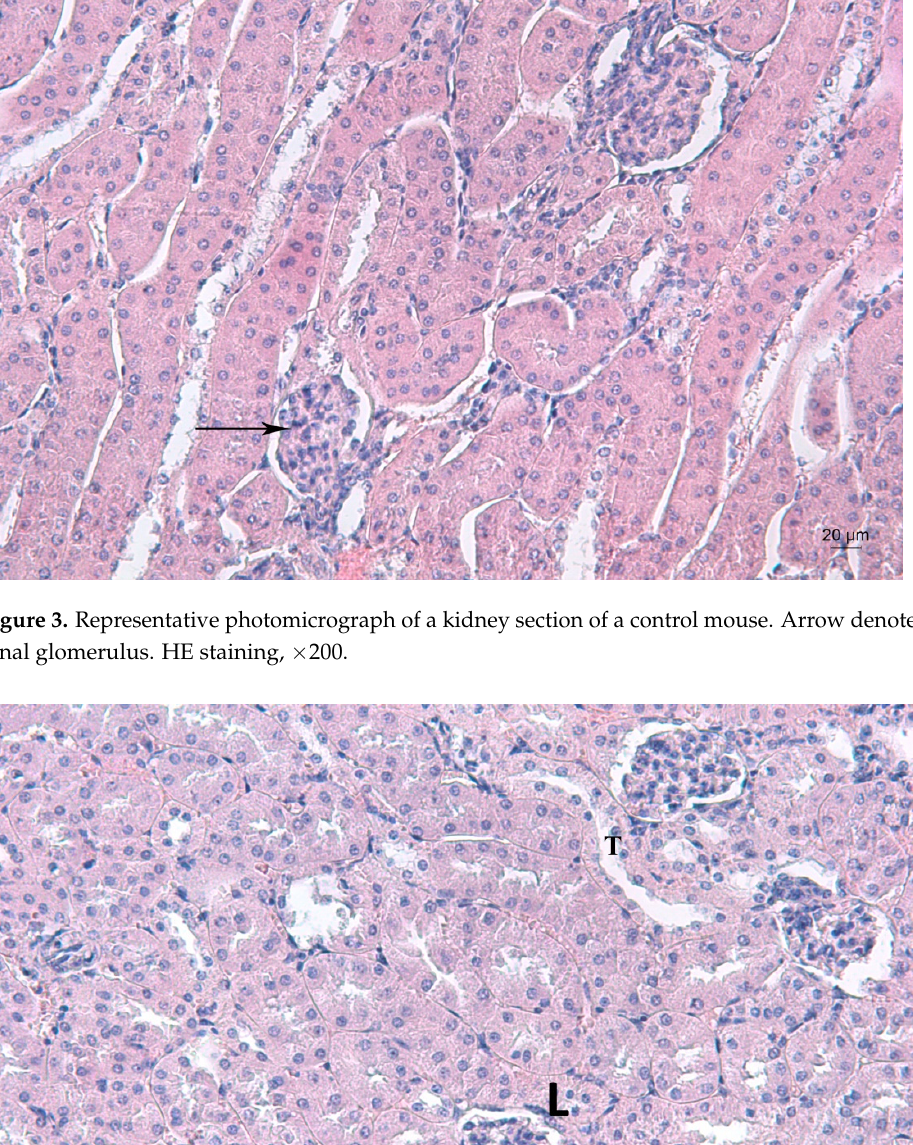
Figure 4. Representative photomicrograph of a kidney section of a Pb-exposed mouse. Arrow represents leukocyte infiltrations (L) near the glomerulus T—altered tubules. HE staining, ×200.